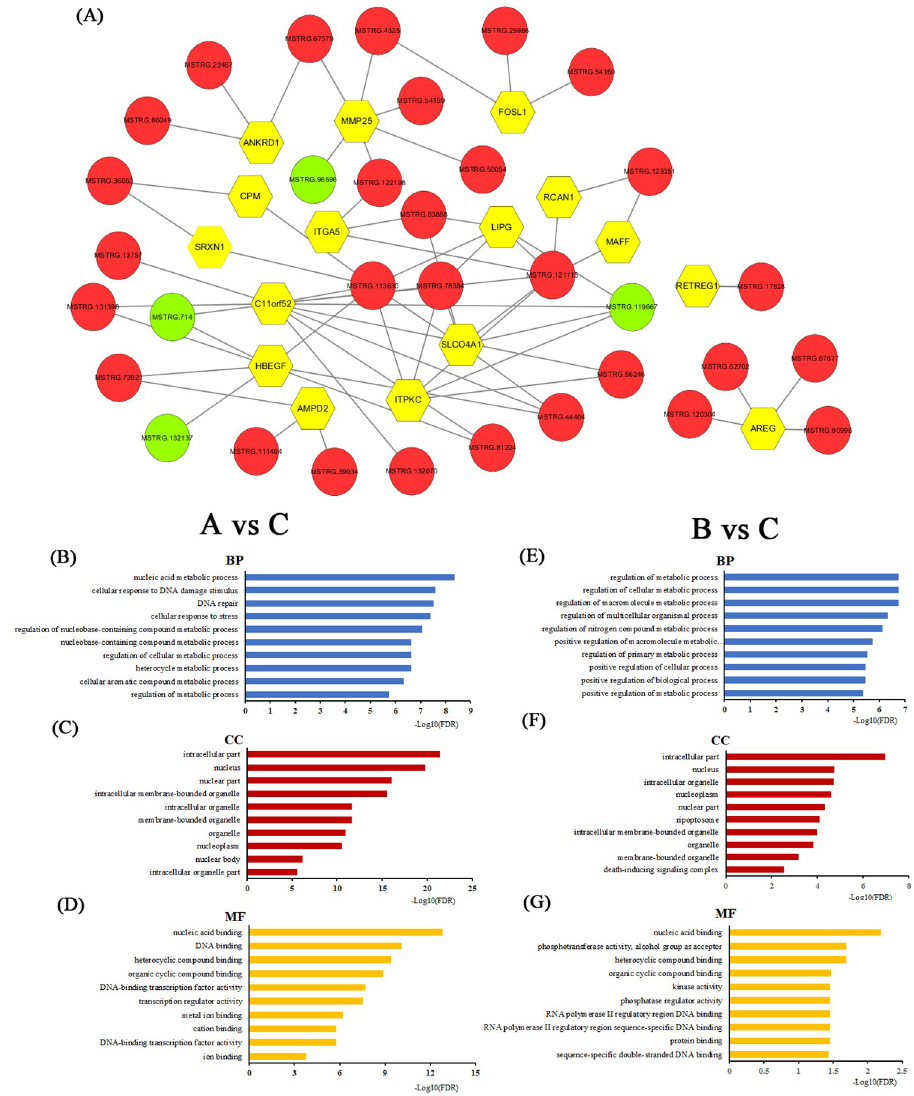
Fig 4. lncRNA-mRNA-network analysis. A. Blue nodes represent upregulated mRNAs; red nodes represent upregulated lncRNAs, and green nodes represent downregulated lncRNAs. B, C, and D illustrate GO analyses of target mRNAs of differentially expressed lncRNAs of the chronic low-temperature acclimation group. E, F and G illustrate GO analyses of target mRNAs of differentially expressed lncRNAs of the acute short cold stress